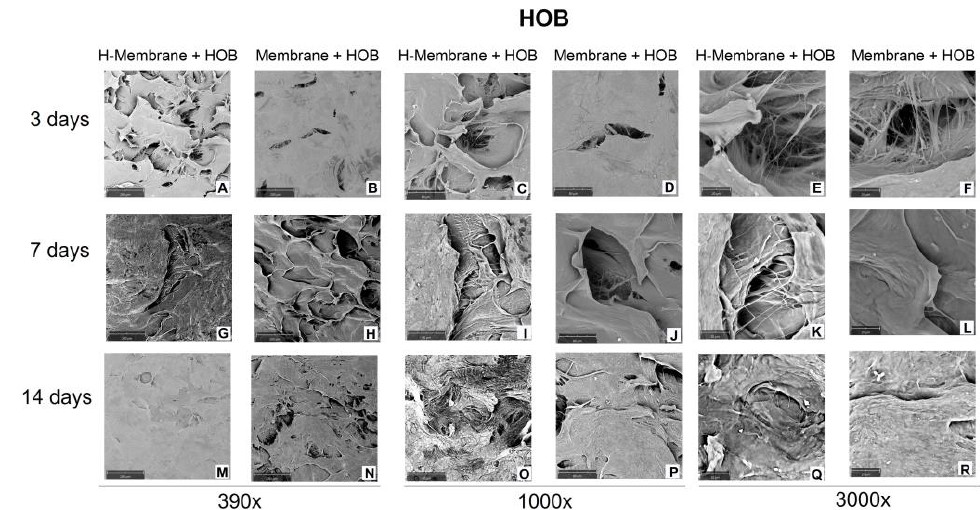
Figure 5. Scanning electron micrograph (SEM) images of HOBs cultured on H-Membrane and Membrane at 3 ( A – F ), 7 ( G – L ), and 14 ( M – R ) days. (Magnification = 390, 1000, and 3000×).